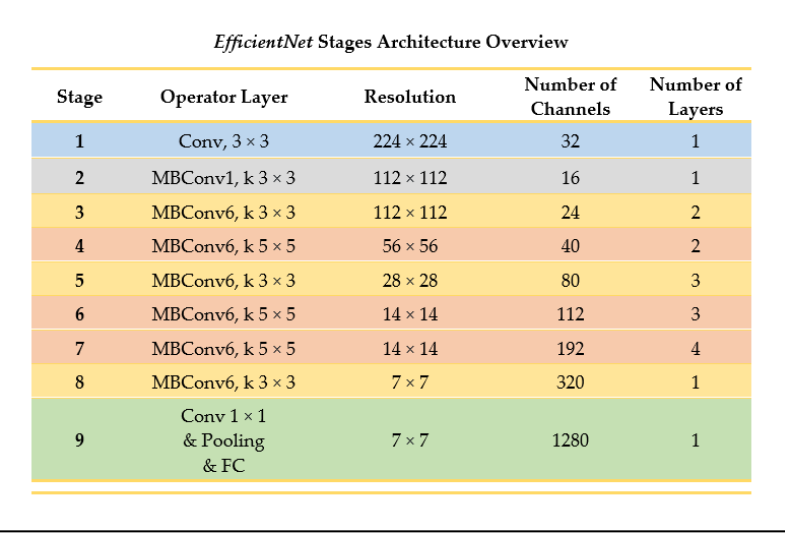
Figure 10. Architecture overview of EfficientNet (as outlined in [27]).